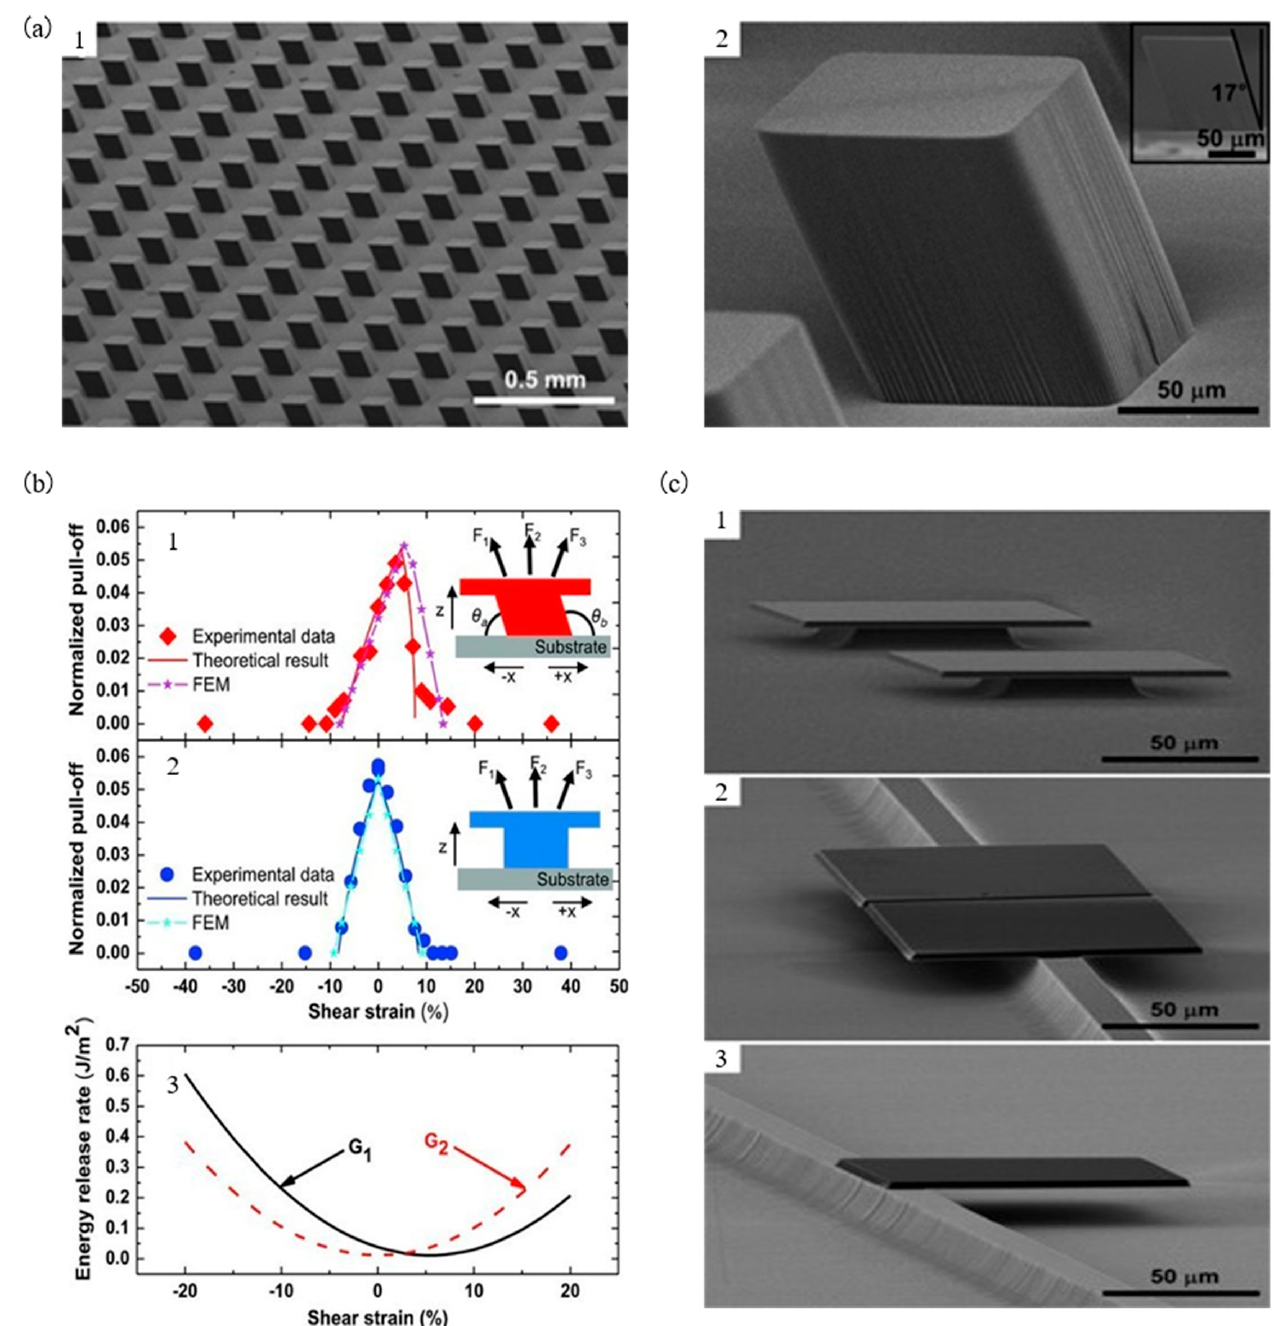
Figure 9. Assist transfer printing technology of a microstructured seal with an oblique column. ( a ) Scanning electron microscope (SEM) image of a seal made by PDMS (reproduced from [62]), ( a1 ) is the microstructure array diagram of the seal with oblique columns, and ( a2 ) is the characteristic diagram of the microstructure design of a single oblique column, ( b ) schematic diagram of the relationship between the adhesion strength of the seal and the shrinkage direction (reproduced from [62]), ( b1 ) is the schematic diagram of the oblique pillar microstructure seal, ( b2 ) is the principle diagram of the pillar microstructure seal, ( b3 ) is the relationship graph between the energy release rate and the shear strain of the oblique pillar (G 1 ) and pillar (G 2 ) microstructure seals, and ( c ) successful example of seal transfer printing with an oblique column structure (reproduced from [62]), ( c1 – c3 ) respectively indicate that the micro device is transferred to the target substrate of the pillar, beam, and cantilever beam structure.